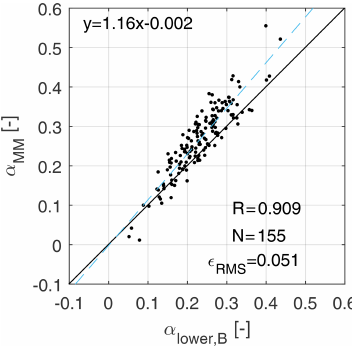
Figure 9. Correlation between the rotor-equivalent (full rotor) ver- tical shear α B and the met-mast shear (up to hub height) α MM , for wind directions from 190 to 200 ◦